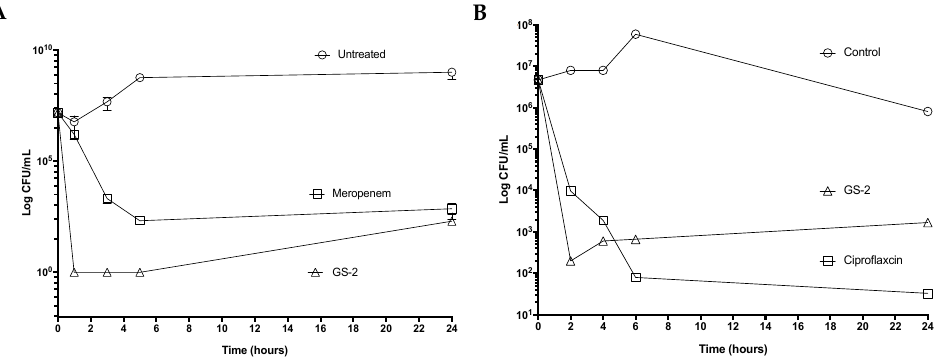
Figure 2. GS-2 exhibits potent antibacterial activity against high-risk bioterrorism pathogens. ( A ) B. thailandensis (1 × 10 6 CFU/mL) was treated with GS-2 at 4.76 mg/mL, meropenem at 0.1 mg/mL, or untreated, and CFU/mL was determined at 0 h, 1 h, 3 h, 5 h, and 24 h. ( B ) B. anthracis vegetative